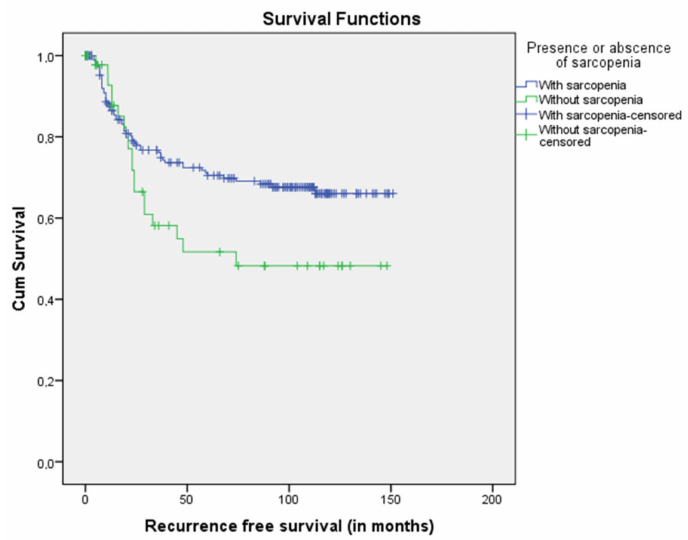
Figure 2. Recurrence-free survival in sarcopenic and non-sarcopenic patients (in months). p = 0.055. Univariate and multivariate Cox regression analyses were performed to assess whether sarcopenia was an independent predictor of recurrence-free survival (Table 6). Table 6. Univariate and multivariate Cox regression analyses of the predictors for recurrence-free